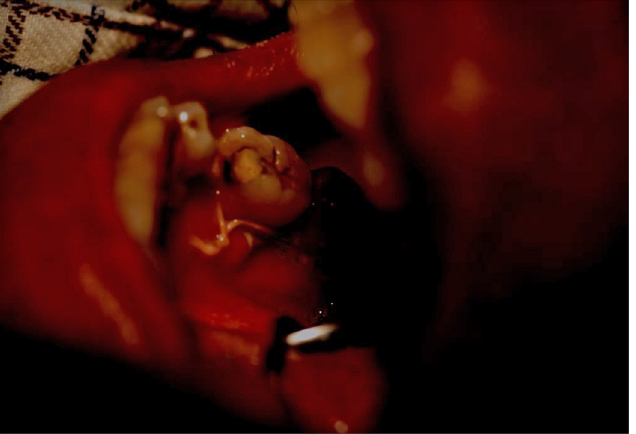
Fig. 4. New anterior elements discovered 20 days after the fi rst element.